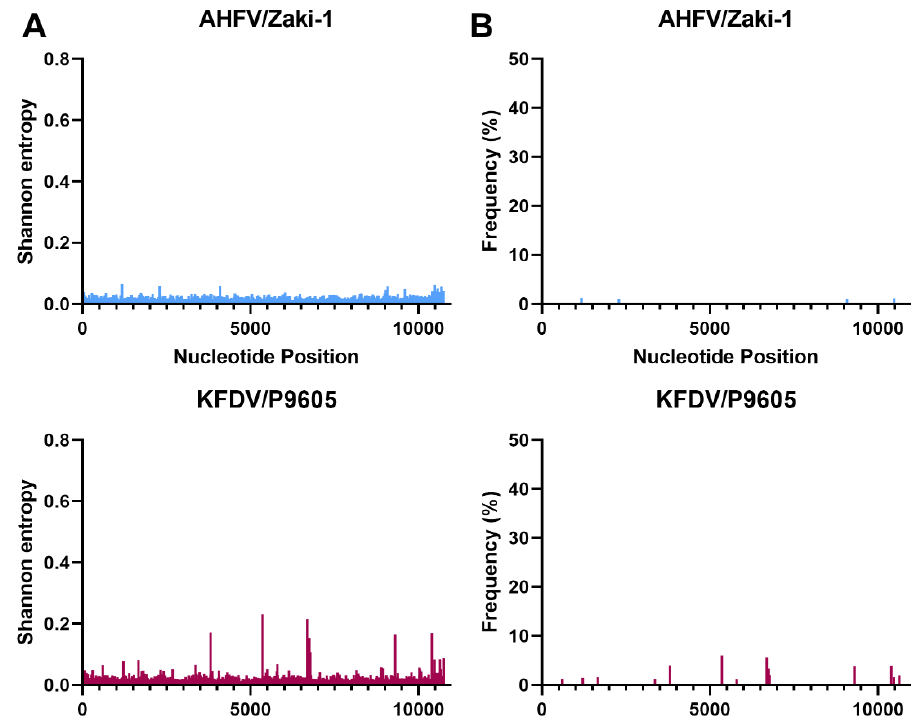
Figure 5. Shannon entropy ( A ) and SNVs ( B ) for AHF and KFD viruses. See Table 1 for details of each sample and virus sample code.